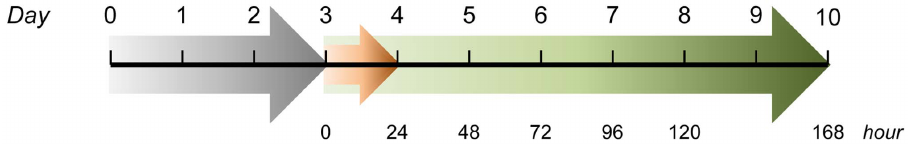
Figure 1. Schematic representation of the experimental procedure. The grey arrow covers the embryoid body (EB) formation stage. Hanging drops were set up on day 0 and EBs formed on day 3. The green arrow depicts the ESC differentiation period, starting from day 3 and ending on day 10. Compound exposure is shown by the orange arrow, which lasted only 24 h (from day 3 to day 4). The numbers on the top are days covering the whole process, while the numbers at the bottom are the time points in hours during ESC differentiation (after EB formation) that were sampled in the present study.